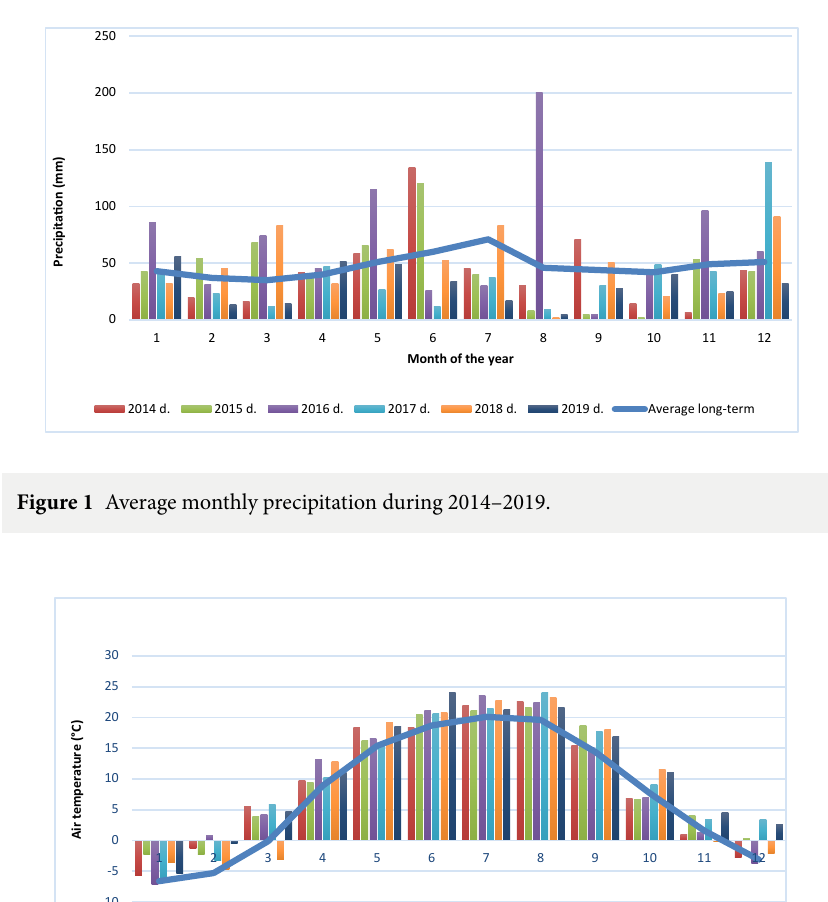
spring exceeded the long-term indicator by 1.8 °C and the amount of precipitation in July was lower by 43.8%. In 2016, a decrease in precipitation in June and July was recorded, which when compared with long-term data, was 33.9 mm and 40.9 mm, i.e., 56.5% and 57.6%, respectively. Moreover, in 2017 weather conditions were characterized by a significant decrease in precipitation in March (65.7%), May and July (47.6%), and June (80.3%) against the background of increased air temperatures. In general, for the spring period, the lack of moisture was 40.2 mm, i.e., 31.9%. is was also the case for two summer months where the lack of moisture measured 82.0 mm, i.e., 62.6%. Only the meteorological conditions of the 2018 growing season, both in terms of precipitation and temperature, were sufficiently favorable for the growth and development of winter wheat plants. In 2019, the air temperature in the spring period exceeded the long-term average by 2.9 °C, while the amount of precipitation was within the long-term value. Among the summer months, the highest increase of the long-term average air temperature was 4.7 °C measured in June. Regarding precipitation, during the period of the highest moisture consumption by winter wheat plants, June and July, 34.2 mm and 17.1 mm, respectively, of rain actually fell. is is less than the long-term indicator, which is 31.0 mm and 60.0 mm, respectively. Statistical data processing was carried out using descriptive statistics, regression, and analysis of variance in STATISTICA 10.0 soware. e significance of the experimental data was evaluated using analysis of variance (ANOVA) to calculate the least significant difference LSD 05